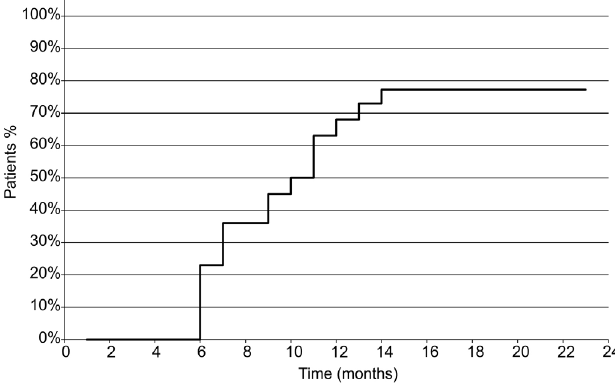
FIGURE 3 - Time required for patients to achieve CR. Patient monitoring was performed for 2 years.